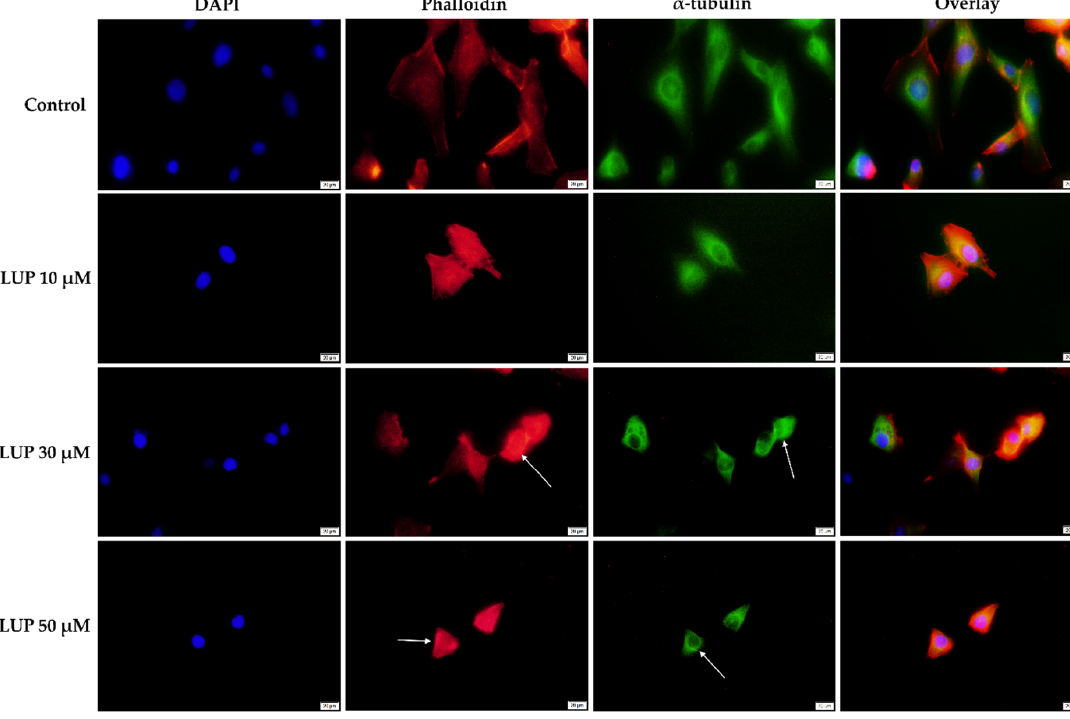
Figure 5. Human melanoma cells ( RPMI-7951) visualized by fluorescence microscopy following the 24 h treatment with LUP (10, 30, and 50 µM). Cell nuclei (DAPI), actin filaments (phalloidin), and microtubules (α-tubulin) are presented individually and combined (overlay). The scale bars indicate 20 µm.